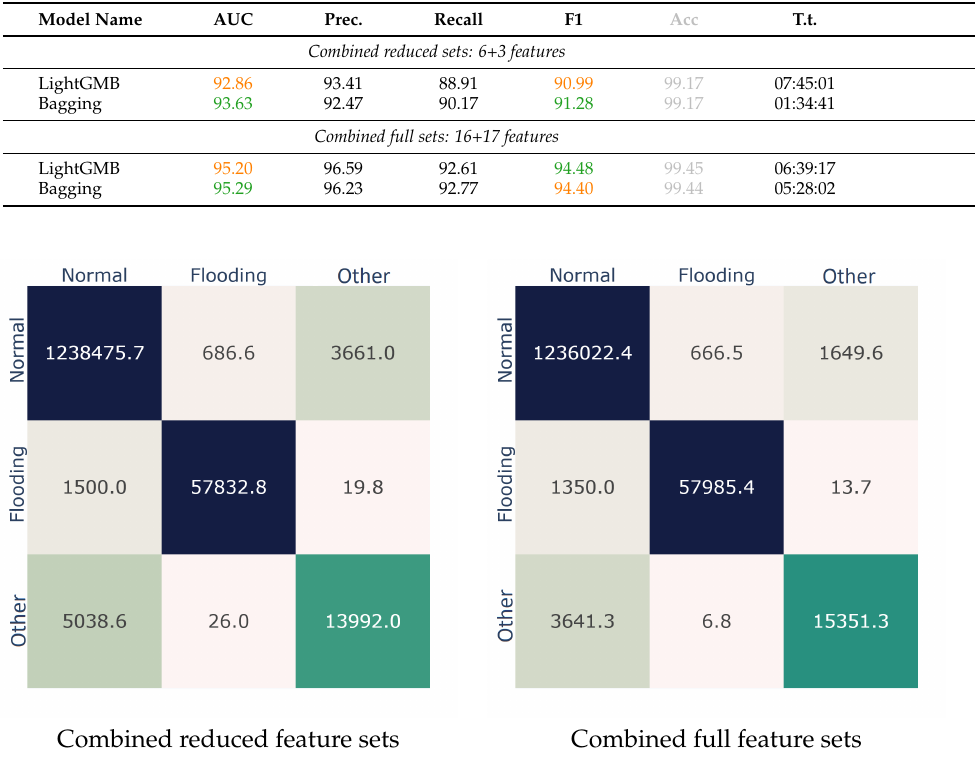
Figure 6. Best performer (bagging) confusion matrices considering the analysis of either reduced set ( left ), or full set ( right )